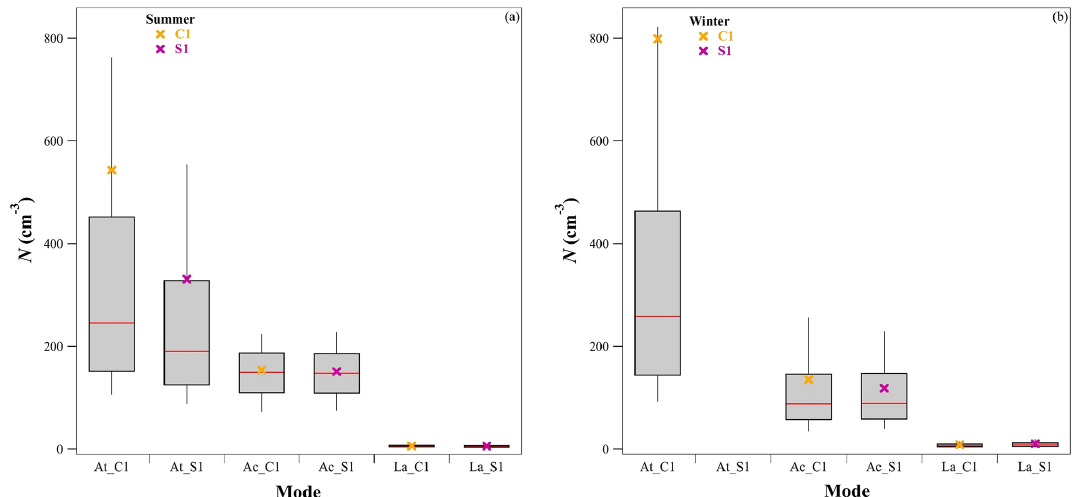
Figure 4. Box and whisker plot of At-, Ac- and LA-mode aerosol number concentrations at C1 (orange) and S1 (pink) in the (a) summer and (b) winter. Mean (x) and median (red line). Box bottom at 25%, box top at 75%, whisker bottom at 10%, and whisker top at 90%. No At-mode data were available at S1 during the